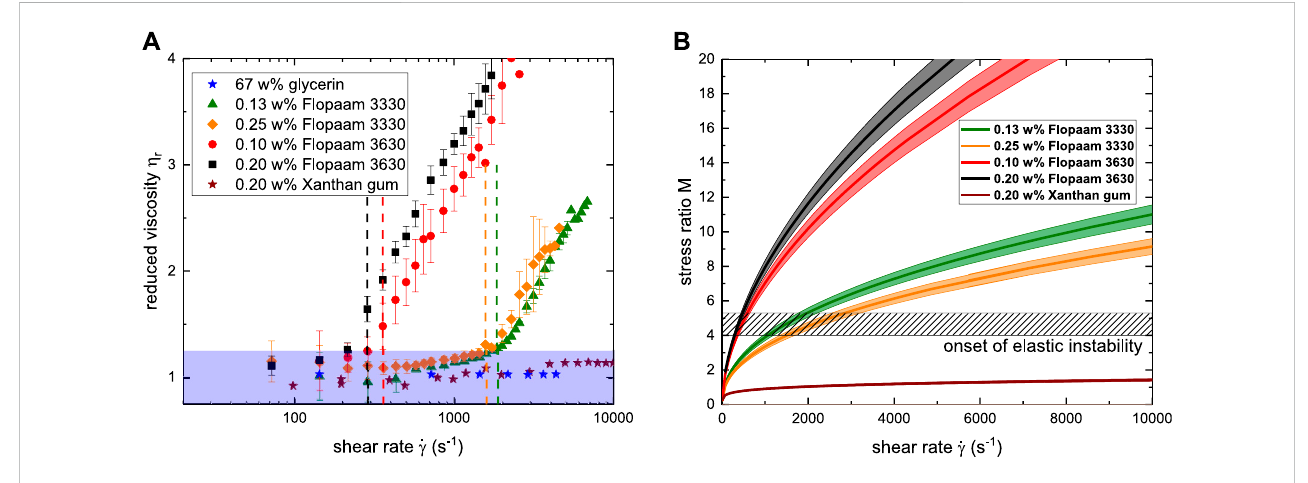
FIGURE 9 (B) stressratio M asfunctionofshearrate _ γ .Thesymbolsin (A) representdatafor67 w% glycerin(bluestar),0.13 w% Flopaam (A) Reducedviscosity η r and 3330 (orange diamond), 0.25 w% Flopaam 3330 (green triangle), 0.10 w% Flopaam 3630 (red circle), 0.20 w% Flopaam 3630 (black square), and 0.20 w% Xanthan gum (brown star). The blue area in (A) indicates a laminar base fl ow where η r < 1.15. The dashed vertical lines in (A) as well the shaded area in (B) indicate the onset of purely elastic